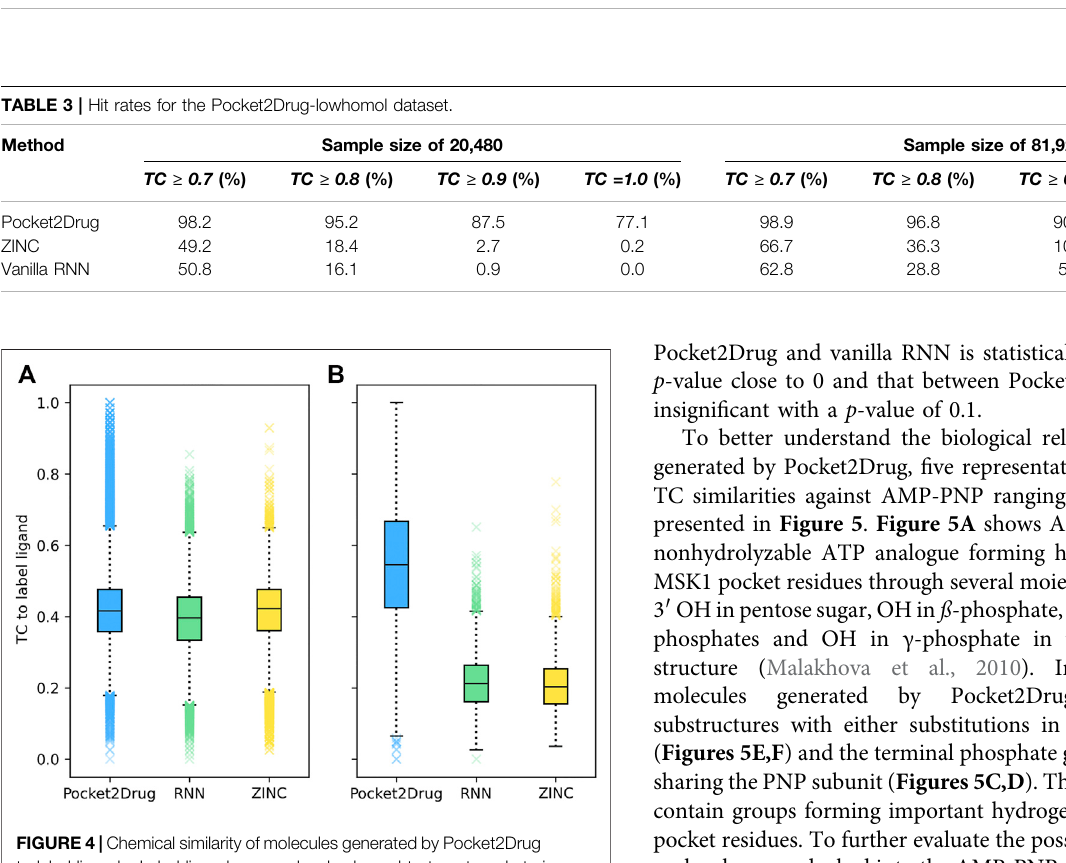
Frontiers in Pharmacology |